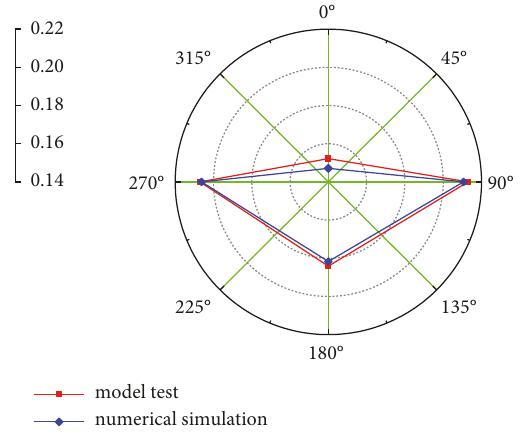
Figure 12: Radar map of peak